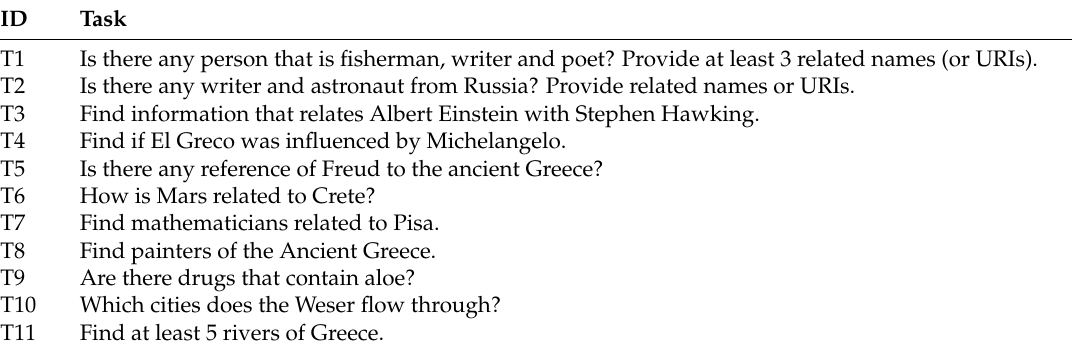
Table 3. Evaluation Tasks.